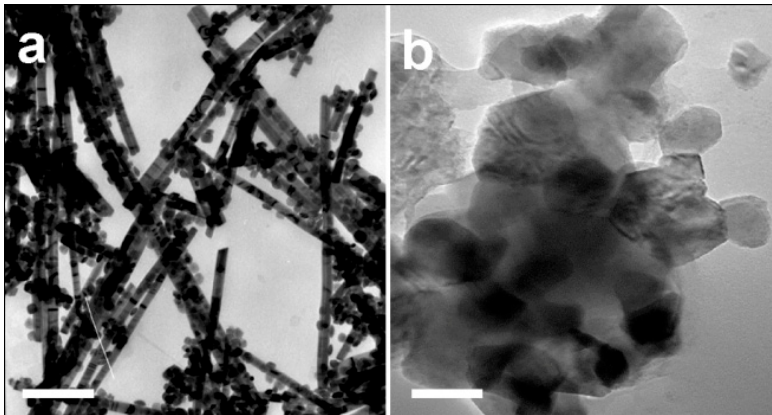
Figure 3. TEM images of different nonmetallic-nonmetallic heterodimers. Fe 2 O 3 -CdS heterodimers, scale bar: 300 nm, reproduced with permission from [134], copyright (2009) American Chemical Society ( a ), and CoFe 2 O 4 -ZnO heterodimers, scale bar: 50 nm, with permission from [137], copyright (2013), Elsevier ( b